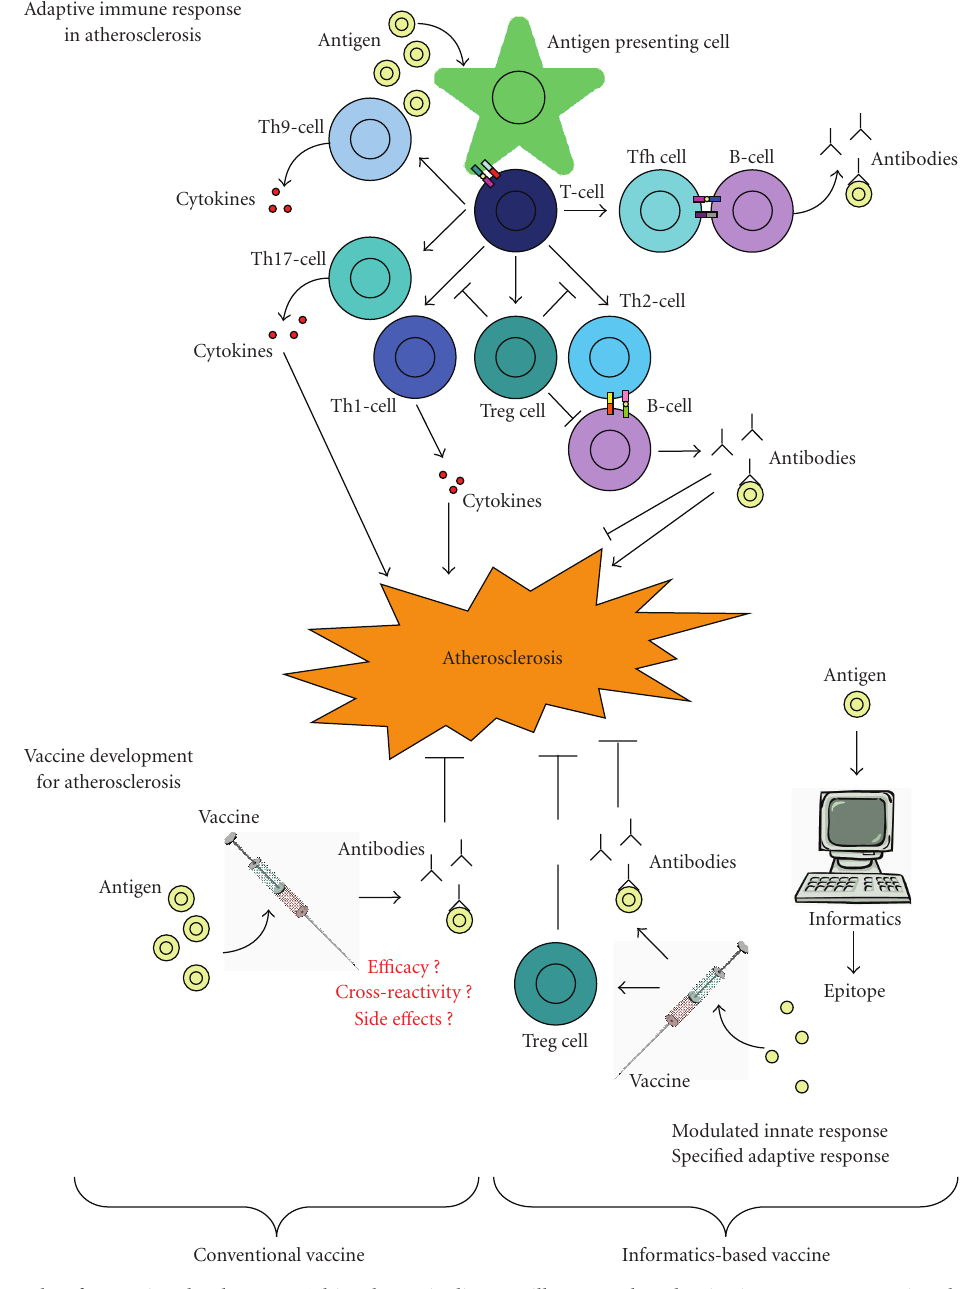
Figure 1: Approaches for vaccine development. This schematic diagram illustrates the adaptive immune response in atherosclerosis (top) as well as the conventional approach (bottom left) and our proposed bioinformatic approach (bottom right) to vaccine development for